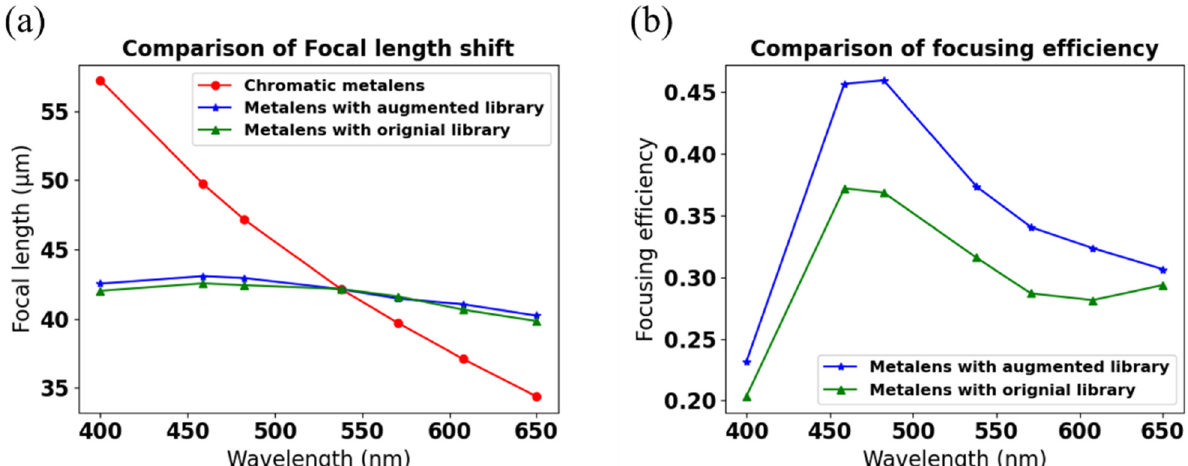
Figure 6. Comparison of the focal length shift and focusing efficiency at operating wavelengths. ( a ) Focal length shift; ( b ) focusing efficiency.